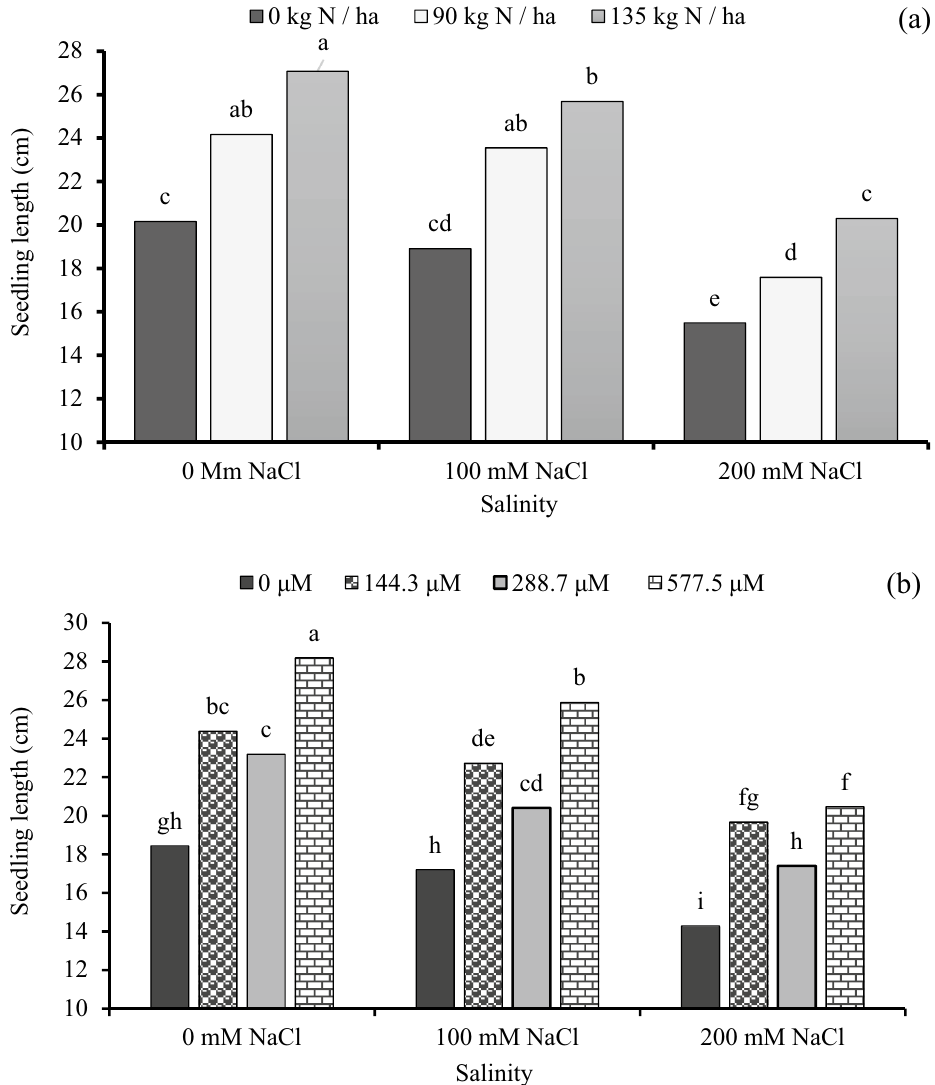
Figure 1. The effect of interaction between: ( a ) different concentrations of salinity × different concentrations of nitrogen and ( b ) different concentrations of salinity × different concentrations of gibberellic acid (GA 3 ) on seedling length (cm) of sorghum seedling. Bars with different letters are significantly different at the 0.05 probability. Means were separated by the LSD test.